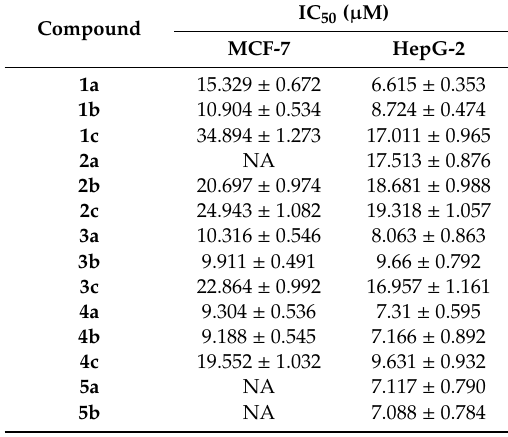
Table 1. IC 50 of the tested compounds 1–5 against the MCF-7 and HepG-2 cell